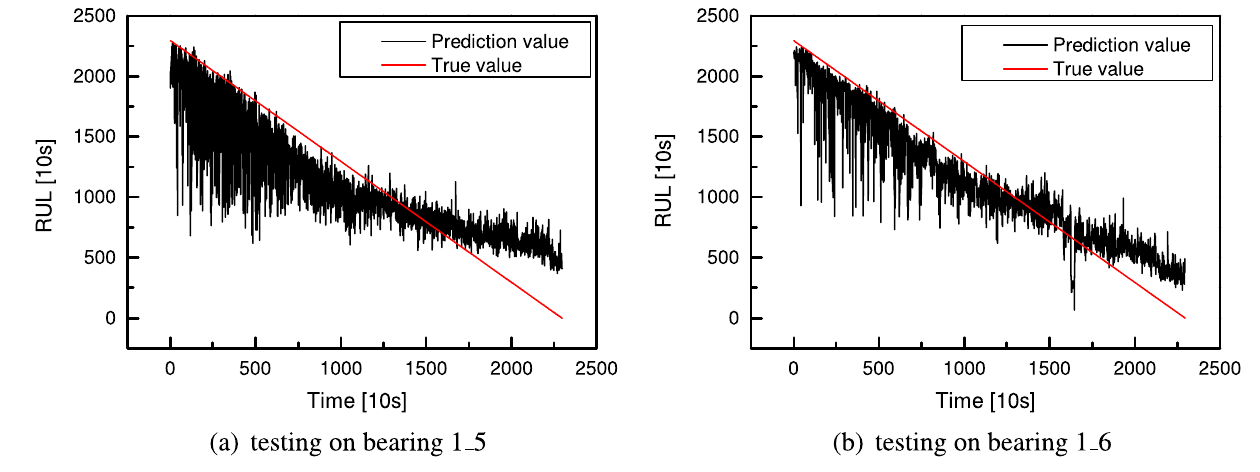
Figure 20. RUL prediction for testing bearing 1_5 ( a ) and bearing 1_6 ( b ) using CNN with four cells.